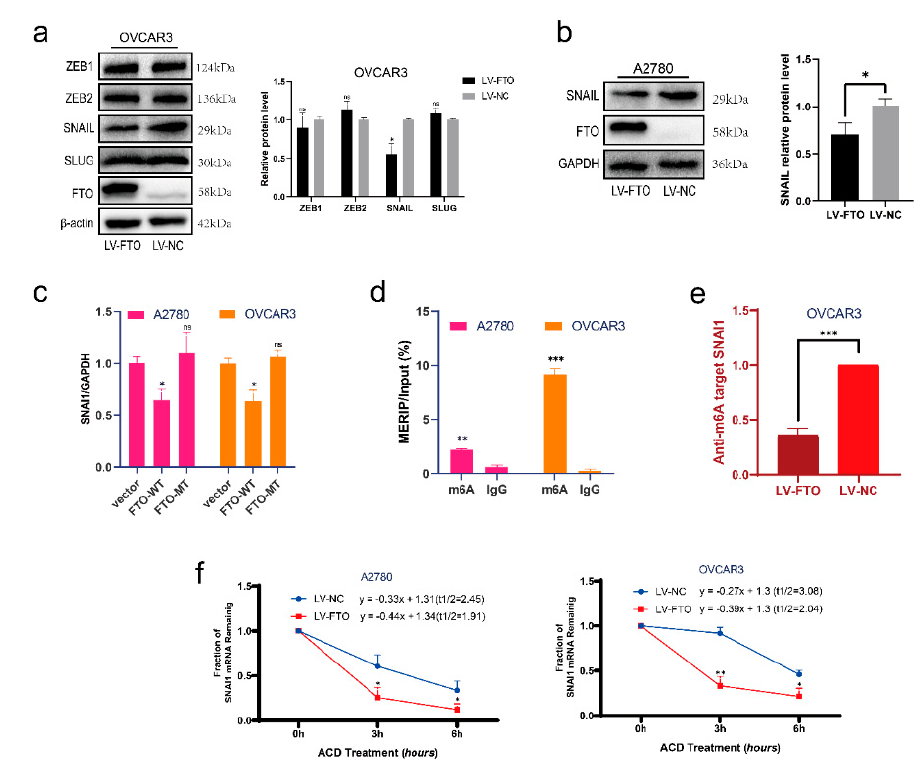
Figure 4. FTO decreases the stability and expression of SNAI1 mRNA. ( a ) Expression of EMT-related transcription factors, ZEB1, ZEB2, SNAIL and SLUG in OVCAR3 cells was determined by Western blot. ( b ) Expression of SNAIL in A2780 cells with indicated treatments detected by Western blot. ( c ) The expression of SNAI1 mRNA in FTO-WT overexpression, FTO-MT overexpression, and control vector transduced A2780 and OVCAR3 cells was examined by RT-qPCR. ( d ) MeRIP assay detected the m6A-modification on SNAI1 mRNA in A2780 and OVCAR3 cells. ( e ) The m6A level of SNAI1 mRNA in LV-FTO or LV-NC OVCAR3 cells was detected by MeRIP. ( f ) After treatment of cells with 10 μ g/mL of ACD for 0, 3, and 6 h, SNAI1 mRNA level in LV-FTO or LV-NC cells was detected by